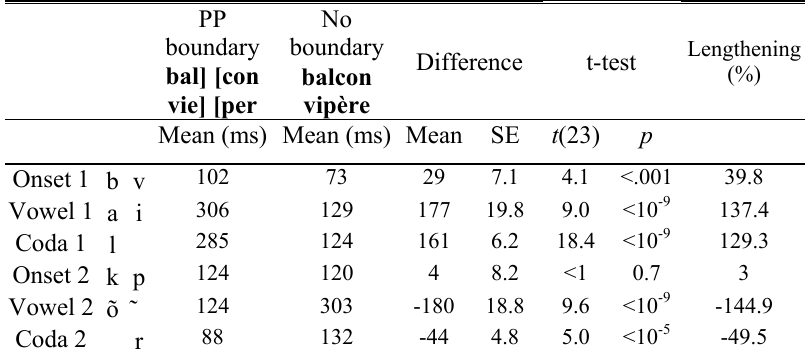
Table 1: Duration of the segments comprising the critical sequences (‘balcon’ and